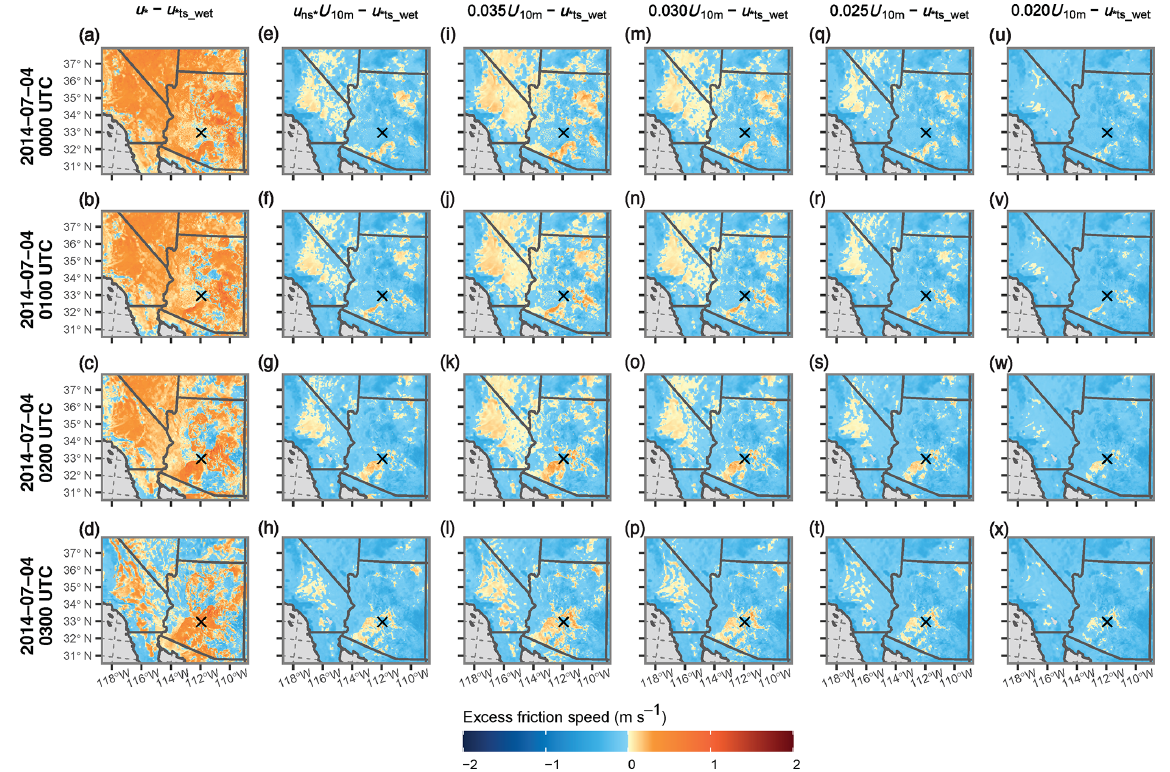
Figure 10. Times series of excess friction speed ( u ∗ ex ; ( u ∗ ex ; ms − 1 ) calculated by subtracting the friction speed for a 69µm diameter particle, u ∗ ts (D s , p = 69µm, θ ), from the wind forcing parameter driving dust production from 00:00 to 03:00UTC on 4 July 2014. The u ∗ ts_wet symbol used in the figure labeling represents u ∗ ts (D s , p = 69µm, θ ). Plots provided include (a–d) u ∗ ex calculated using total friction speed, (e–h) surface friction speed determined from the albedo-based drag parameterization, and (i–x) four instances of 10m wind speeds scaled using a global tuning constant as the wind forcing parameter. The black × marks the location of Phoenix,